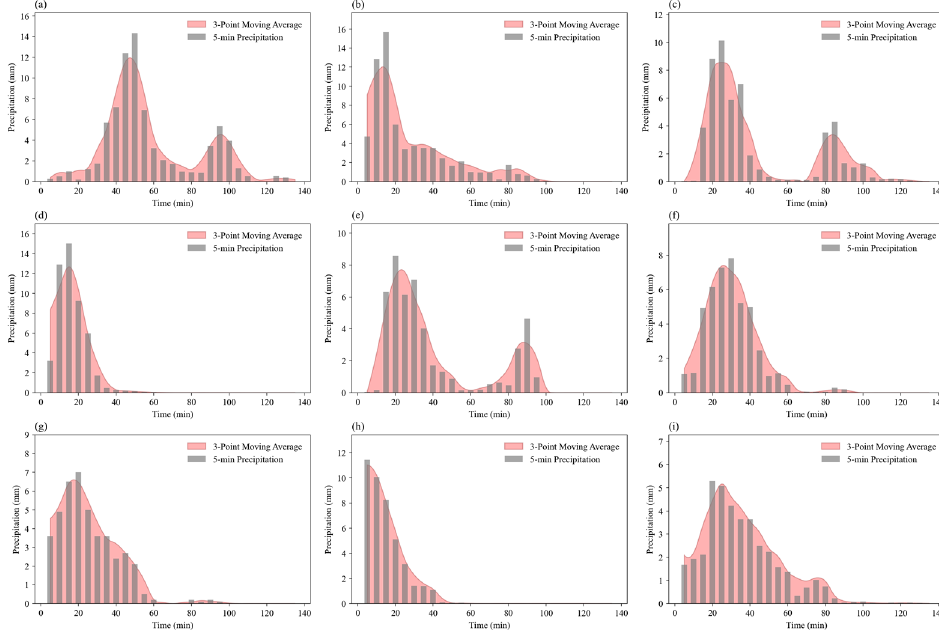
Figure 9. Storm patterns of the 9 maximum rainfall events lasting about 60 min in Nanjing ( a – i ).